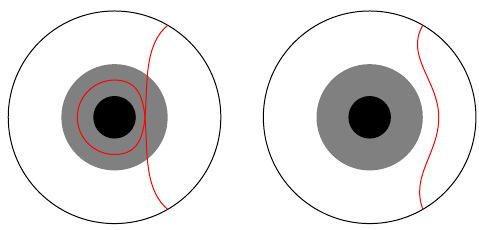
Figure 1 . Geodesics winding around the black hole penetrate the entanglement shadow (shown in gray) while non-winding Ryu-Takayanagi geodesics with minimal length stay outside of the entanglement